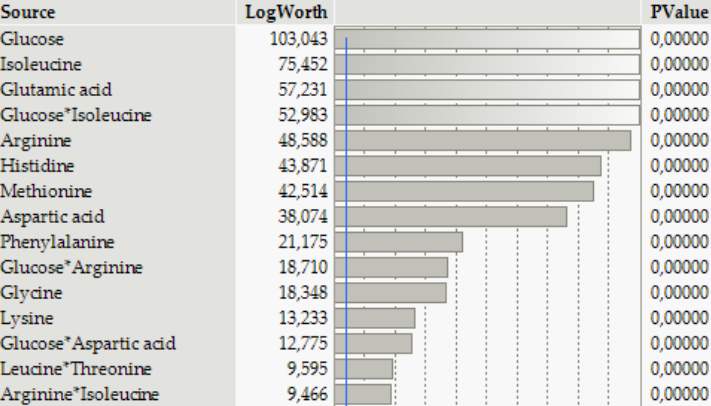
Figure 7. Effect summaries of DoE simulations of the normalized HIV-Gag VLP concentration.